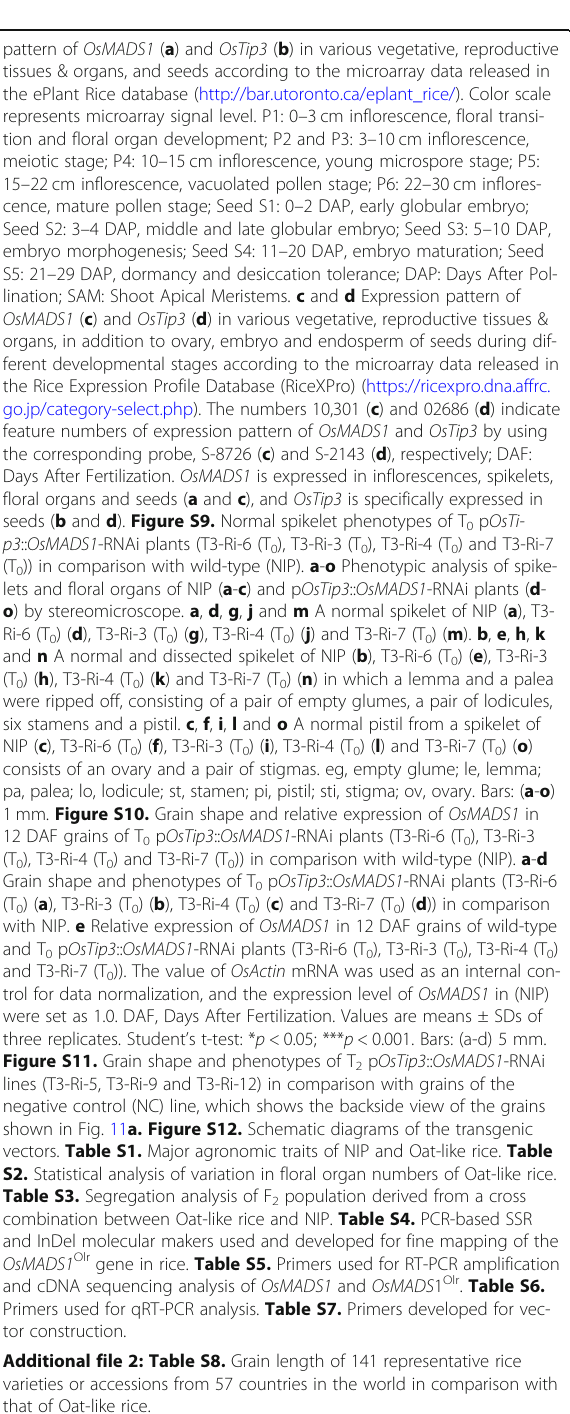
Additional file 2: Table S8. Grain length of 141 representative rice varieties or accessions from 57 countries in the world in comparison with that of Oat-like